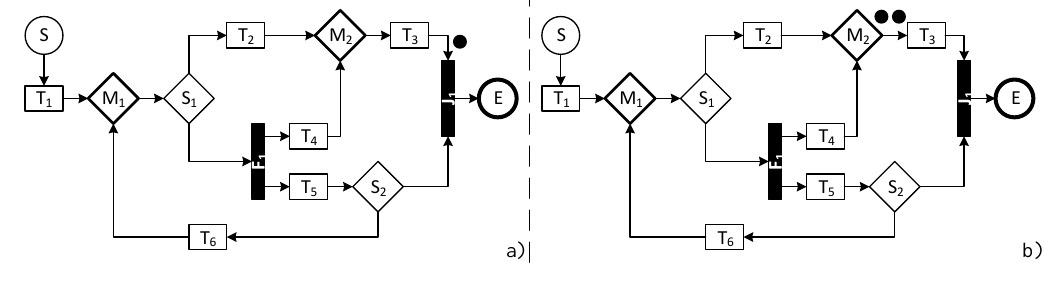
Figure 6. A workflow graph in a deadlock a) and an abundance